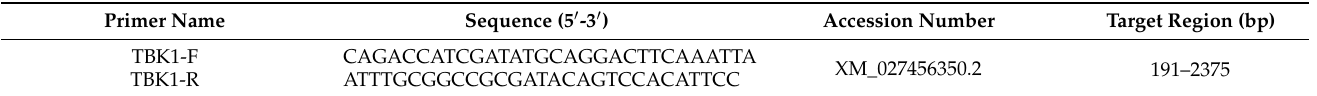
Table 1. Primer sequence for TBK1 gene amplification.